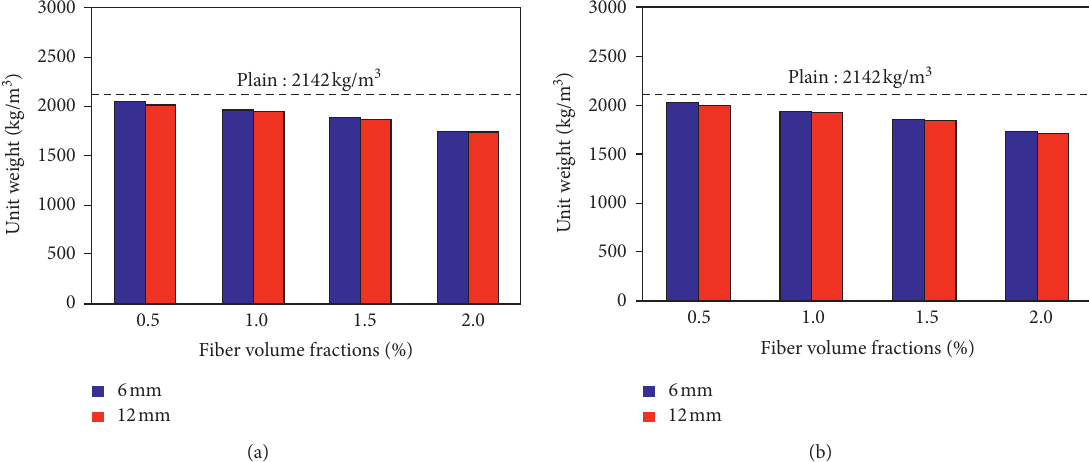
Figure 7: Unit weight test results with different fiber lengths and fiber volume fractions: (a) SiO carbon